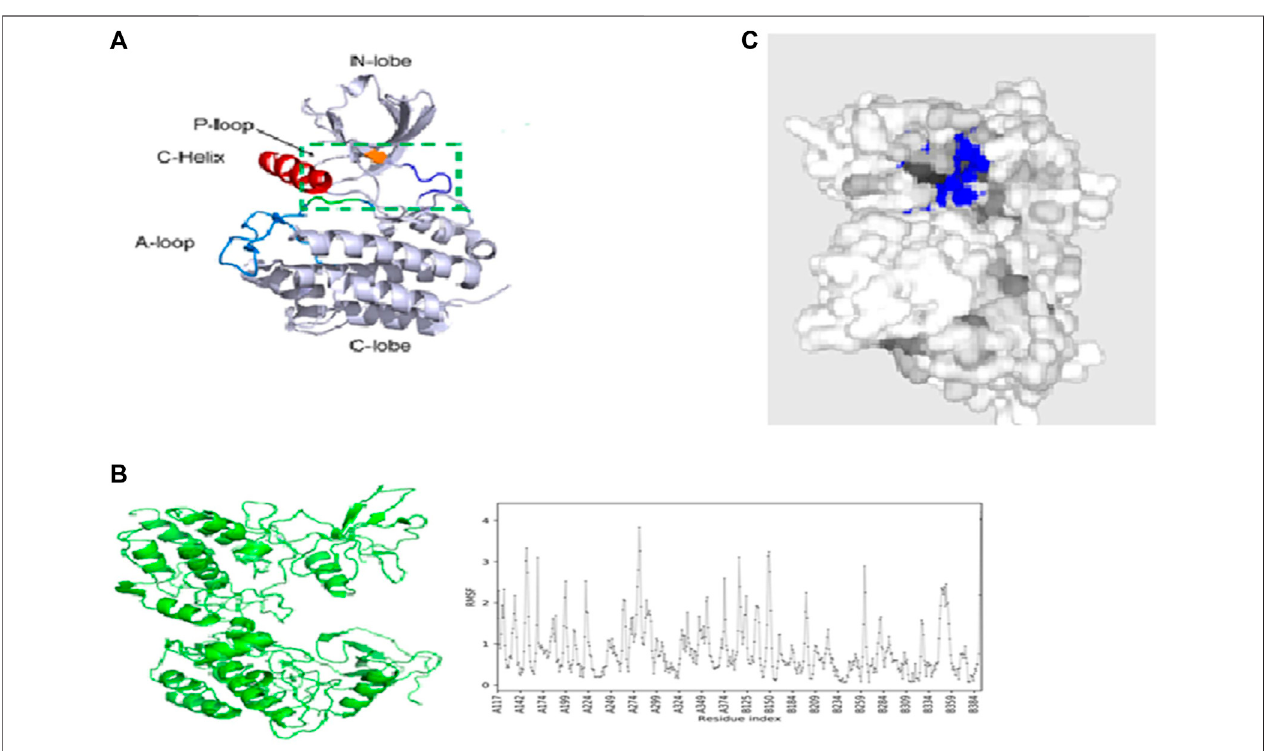
FIGURE 2 | (A) Crystal structure of the ACK1 protein (PDB code: 6VQM); (B) best model of ACK1 from MD simulations with the RMSF graph (CABS- fl ex 2.0 server); (C) best binding pockets (blue color) of ACK1 as predicted by the Prankweb server.